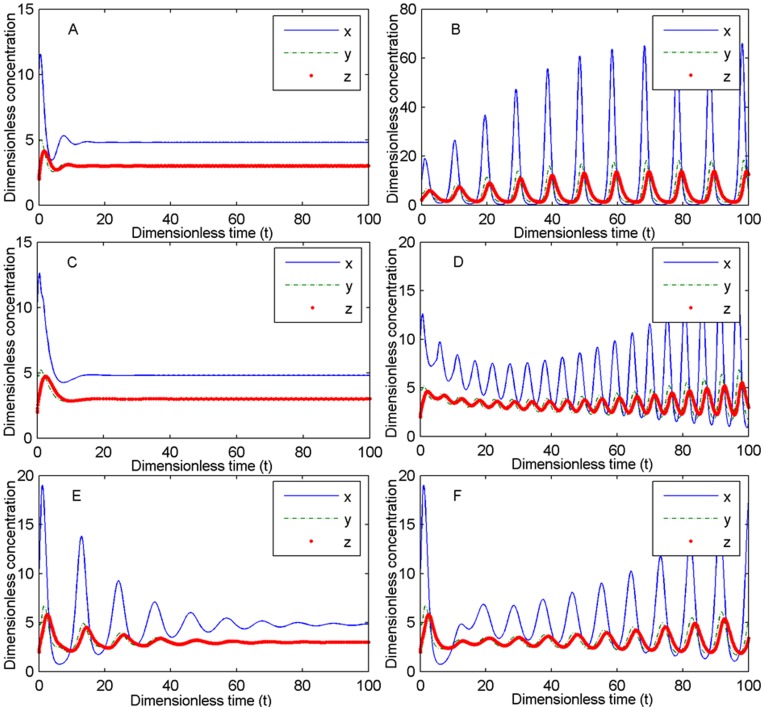
From oscillation caused by the time delays to stability from the time delay τ1.(A). System (2) is stable when τ
1 = τ
2 = τ
3 = τ
4 = τ
5 = 0. (B). System (2) is oscillating, induced by τ
2, τ
3 or τ
5 when τ
1 = 0, τ
2 = 0.3, τ
3 = 0.2, τ
4 = 0 and τ
5 = 0.6. (C). System (2) is stable when τ
1 = 1, τ
2 = 0.3, τ
3 = 0.2, τ
4 = 0 and τ
5 = 0.6. (D). System (2) is oscillating when τ
1 = 5, τ
2 = 0.3, τ
3 = 0.2, τ
4 = 0 and τ
5 = 0.6. (E). System (2) is stable when τ
1 = 0, τ
2 = 0.3, τ
3 = 0.2, τ
4 = 4 and τ
5 = 0.6. (F). System (2) is oscillating when τ
1 = 0, τ
2 = 0.3, τ
3 = 0.2, τ
4 = 9 and τ
5 = 0.6. Other parameters: n
1 = n
2 = 1, σ
1 = 4, σ
2 = 3, α
2 = 2.5 (<), α
4 = 4 and K = 2. The initial values are [10,5,2].